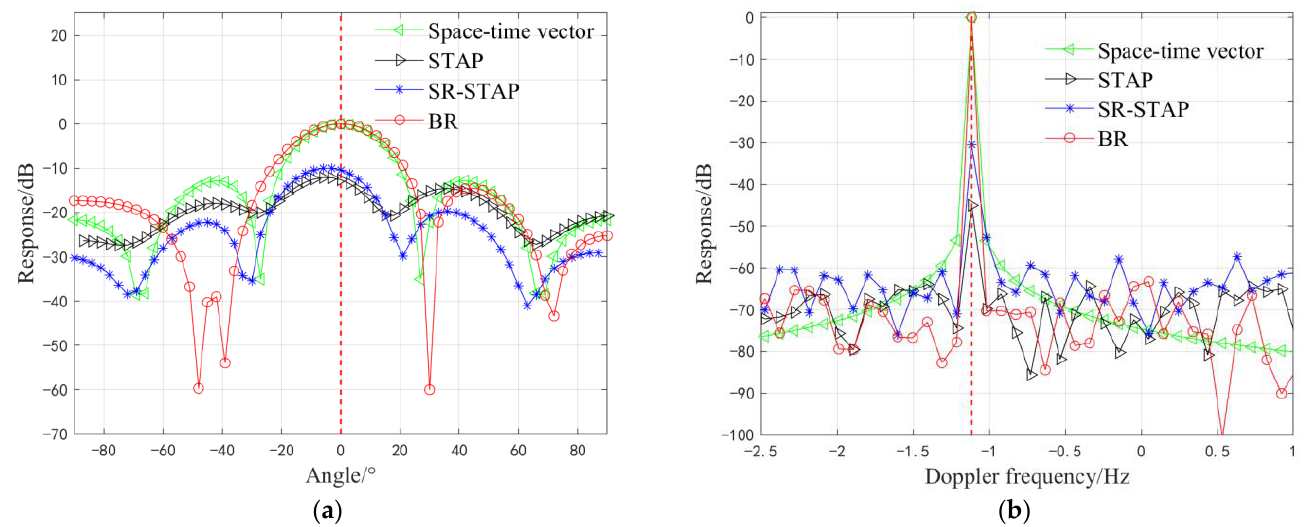
Figure 3. Comparison of response patterns for the weight vector in ( a ) the angle domain and ( b ) the Doppler frequency domain for different algorithms. Doppler frequency domain for different